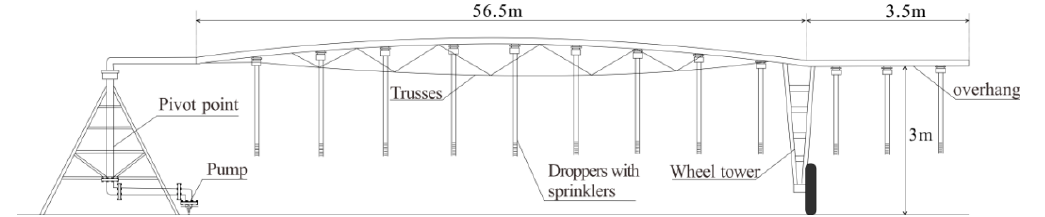
Figure 3. Main units and parameters of the center pivot irrigation system (CPIS).